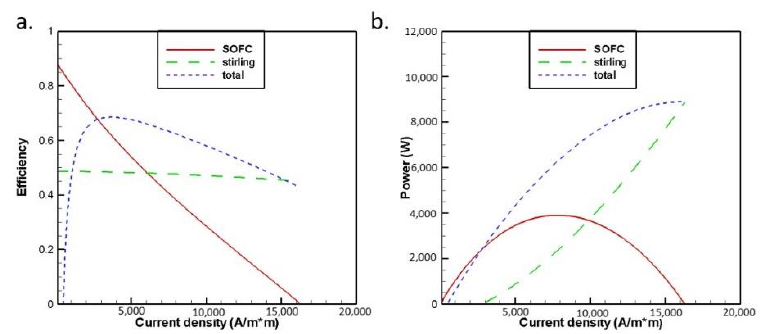
Figure 4. Computed ( a ) efficiency, and ( b ) generated power for different current densities at 873 K for hybrid SOFC-SE system without heat components (Emin [20]).